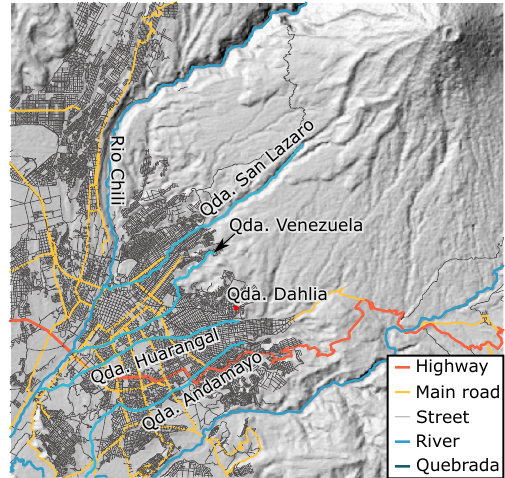
Figure 1. Location of Arequipa in relation to the El Misti vol- cano, showing the main quebradas and the location of the Quebrada Dahlia study